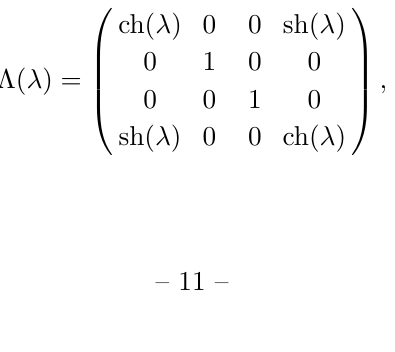
Figure 3 . Examples of graphs contributing to the loop-induced gg (b) has the same topology as a 1v1,pt